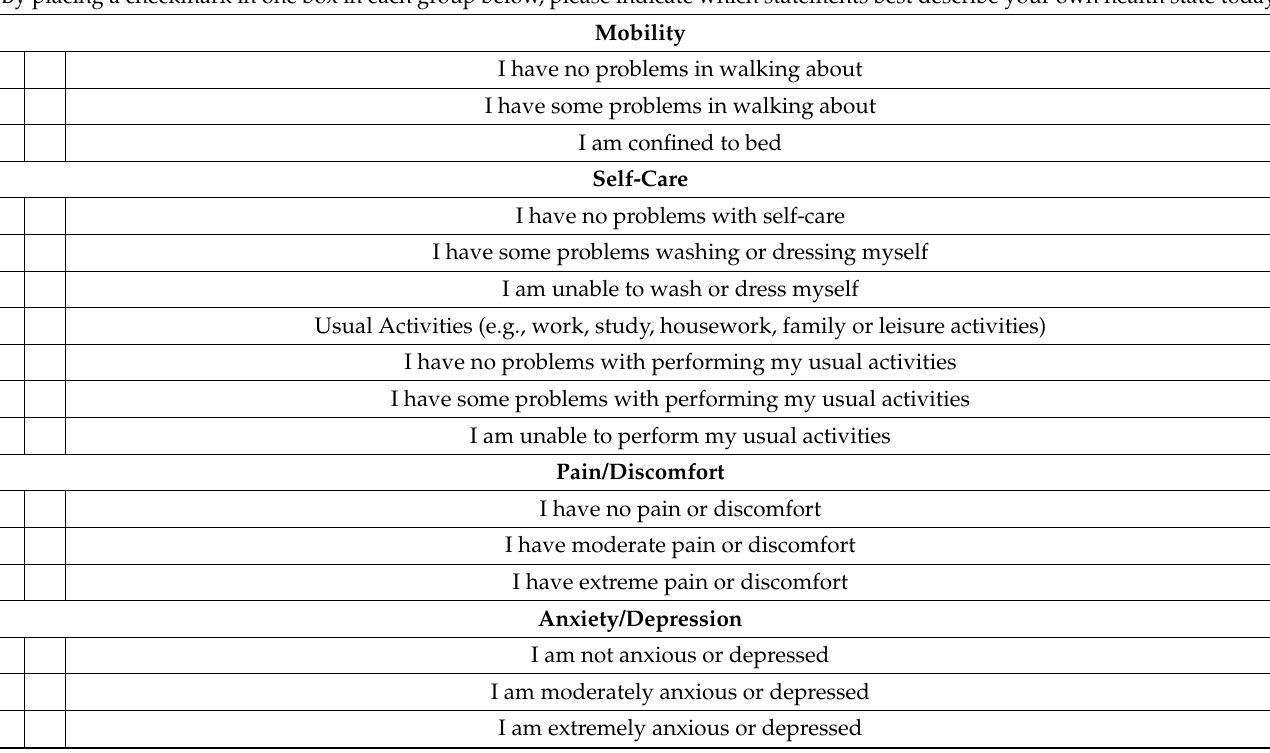
Table A4. EQ-5D [259].